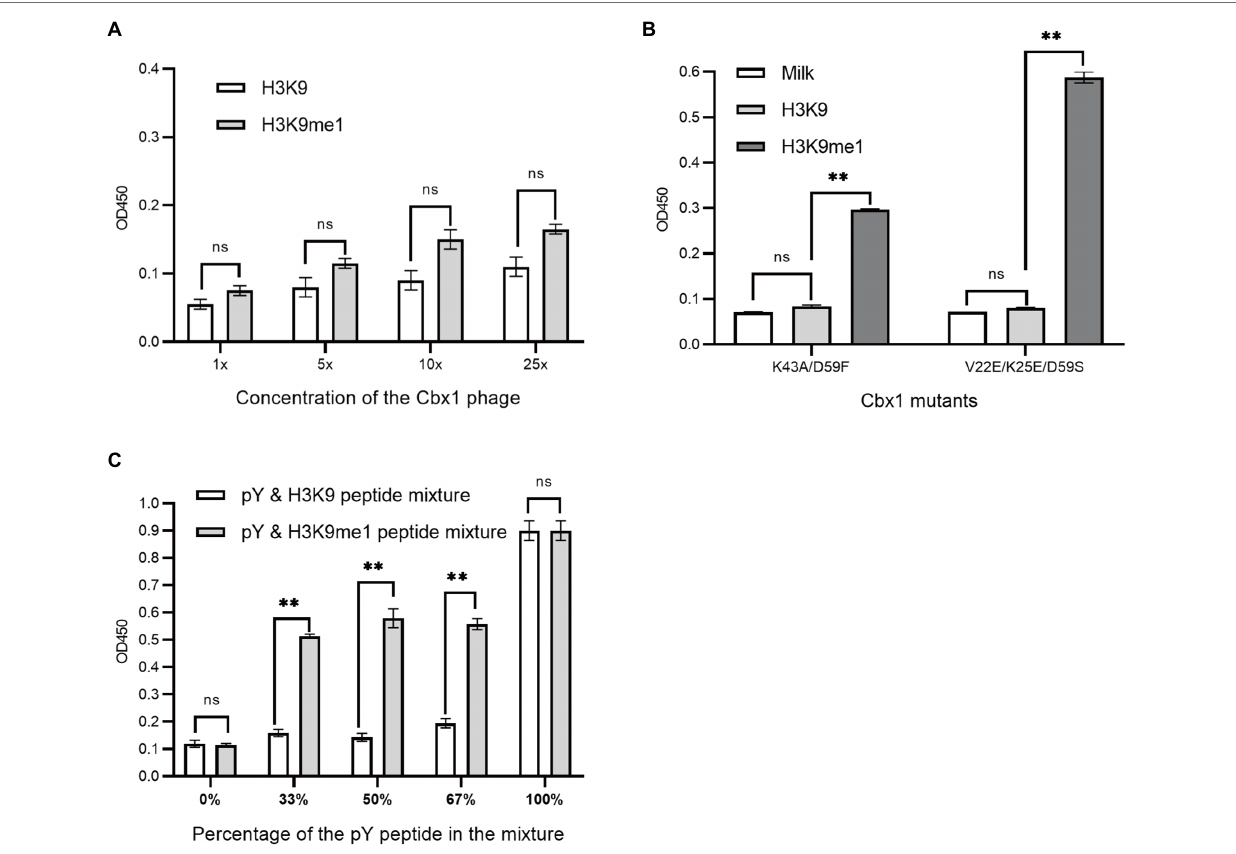
FIGURE 5 | Phage ELISA showed the binding to the H3K9me1 peptide of the Cbx1 protein with different phage concentrations (A) or supernatant Cbx1-mutant- containing phages (B) or the binding of Cbx1-and-FynSH2-containing phage (C) to the mixtures of pY and H3K9me1 peptides with different ratios. The mixtures of pY and H3K9 peptides were considered as negative controls. The experiments were repeated three